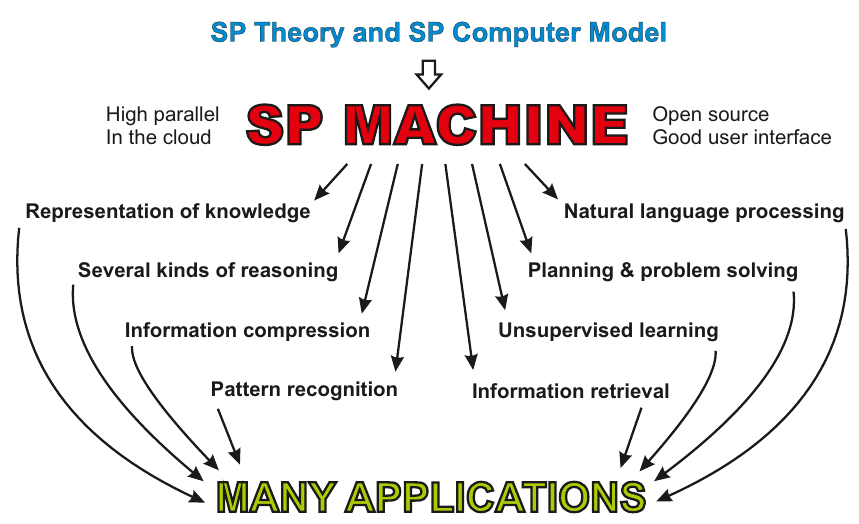
Figure A4. Schematic representation of the development and application of the SP Machine. Repro- duced from Figure 2 in